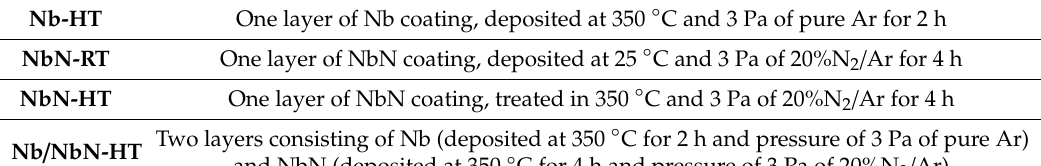
Table 2. Sample labels and PVD coating conditions of each sample.